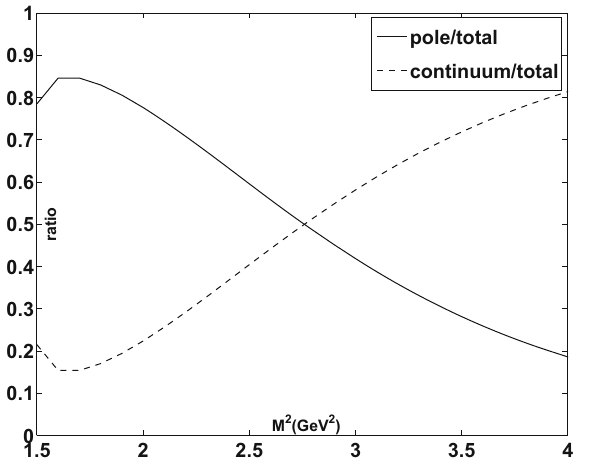
Fig. 2 The phenomenological contribution in sum rule (6) for 4 . 8 GeV for (cid:2) c ¯ D . The solid line is the relative pole contribution (the pole contribution divided by the total, pole plus continuum contribu- tion) as a function of M 2 and the dashed line is the relative continuum contribution